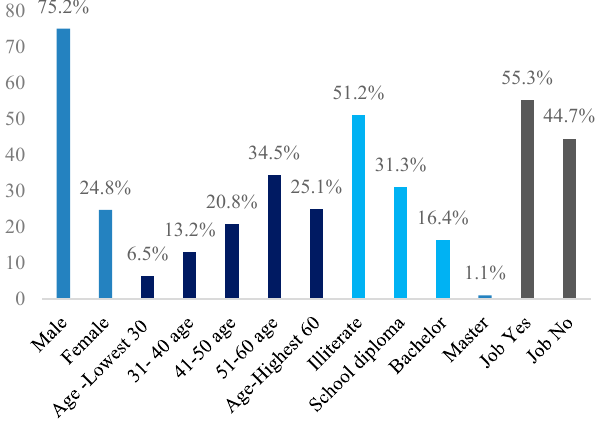
Figure 2. Characteristics of sex, age, education, and employment of all respondents (in percent).